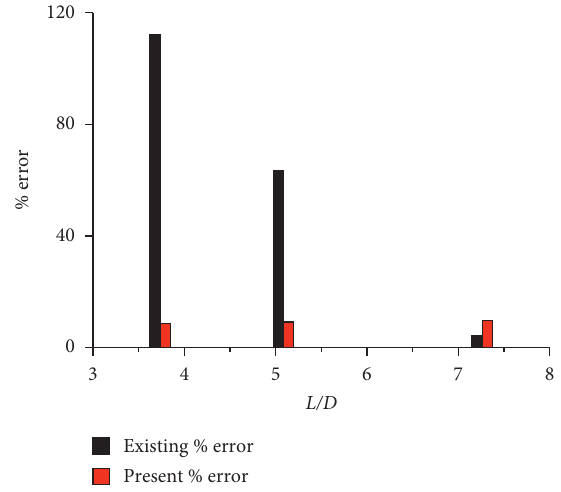
Figure 5: Fundamental frequency comparisons for the present FEM work with existing